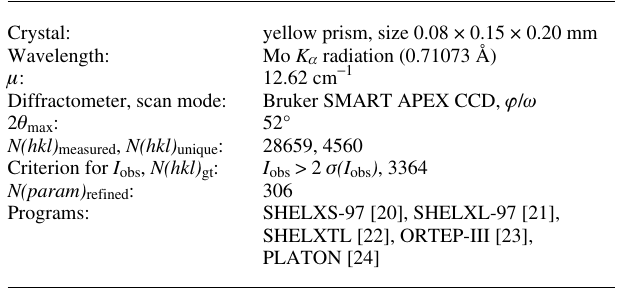
Table 1. Data collection and